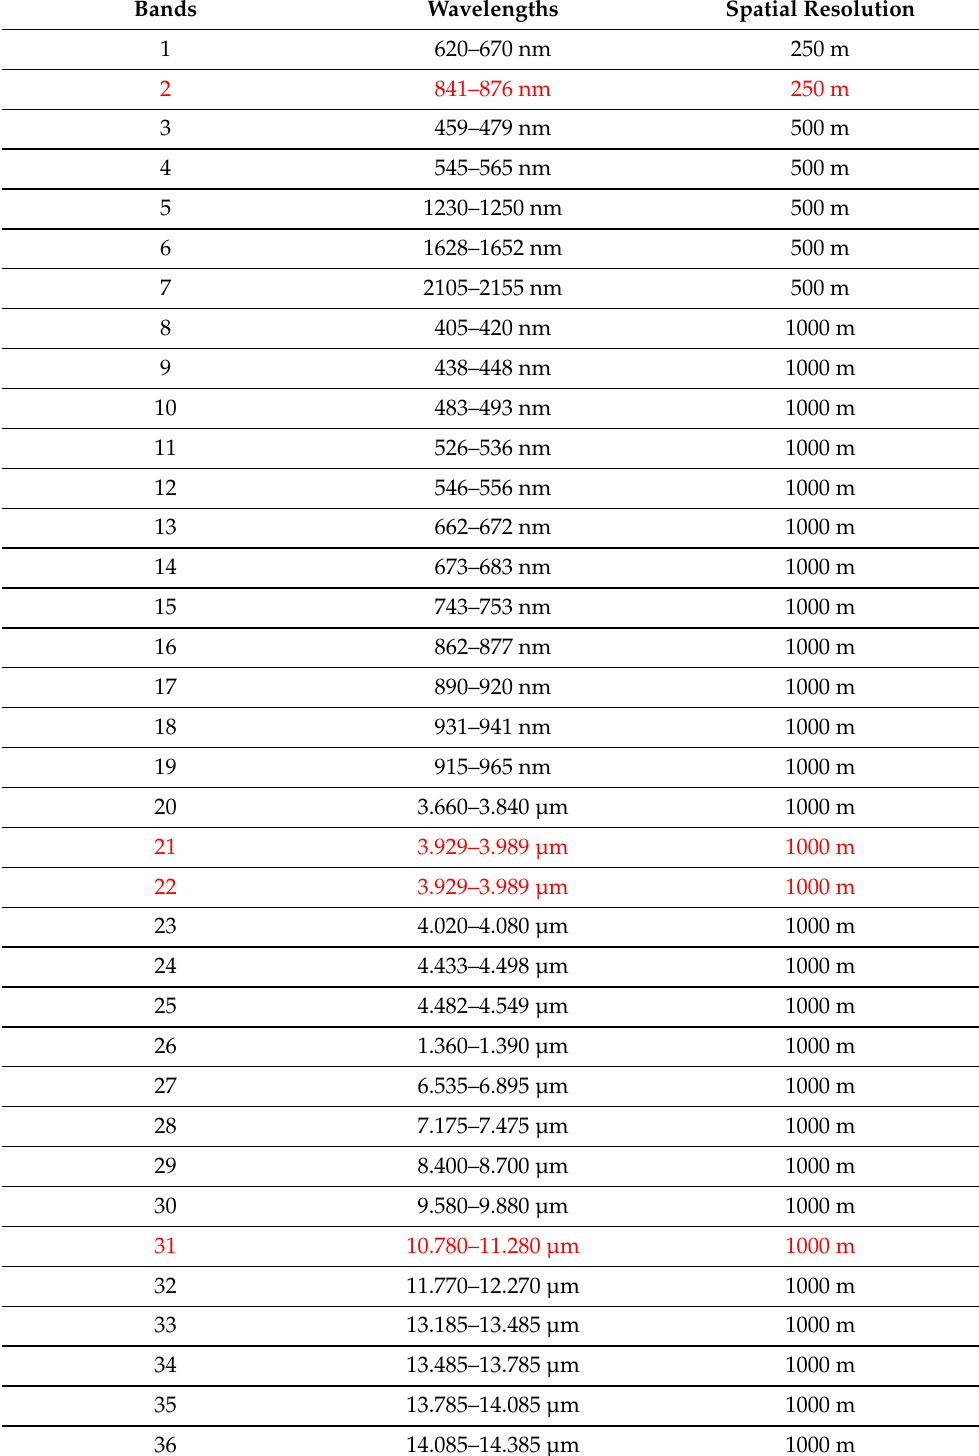
Table 2. MODIS bands (in red, used by the active fire detection